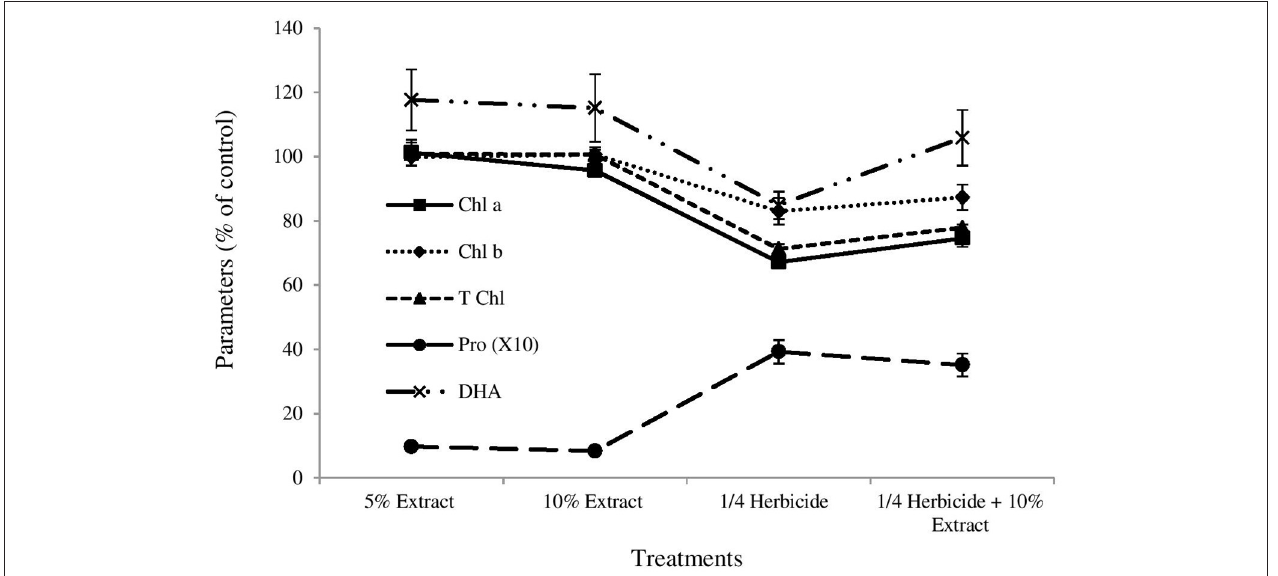
FIGURE 1 | Effects of boneseed extracts, herbicide and mixture on pre-emergent ryegrass. The x-axis denotes the treatment types (5% aqueous extract of boneseed leaf, 10% extract, ¼ strength herbicide, and mixture of ¼ strength herbicide with 10% extract). Values on y-axis denote the impact (% of control) on chlorophyll a (chl a) (solid line with square marker), chlorophyll b (chl b) (round dot line with diamond marker), total chlorophyll (T chl) (square dot line with triangular marker) and proline (pro) (long dash line with circle marker) content of ryegrass, and soil dehydrogenase activities (DHA) (long dash dot dot line with cross marker). The error bar indicates the standard error.